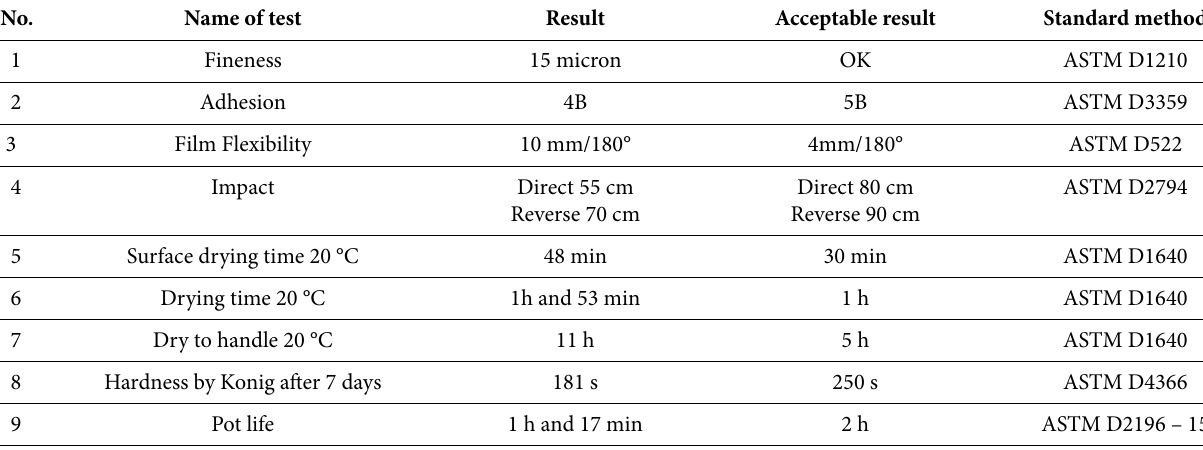
Table 3. Mechanical result of sample PA6